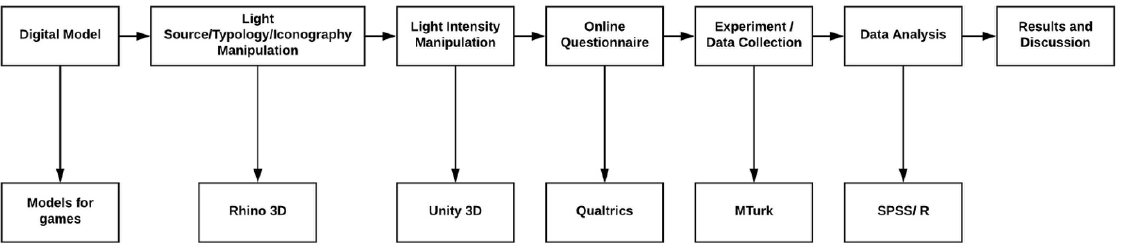
Figure 4. Study’s experimental procedure flowchart .